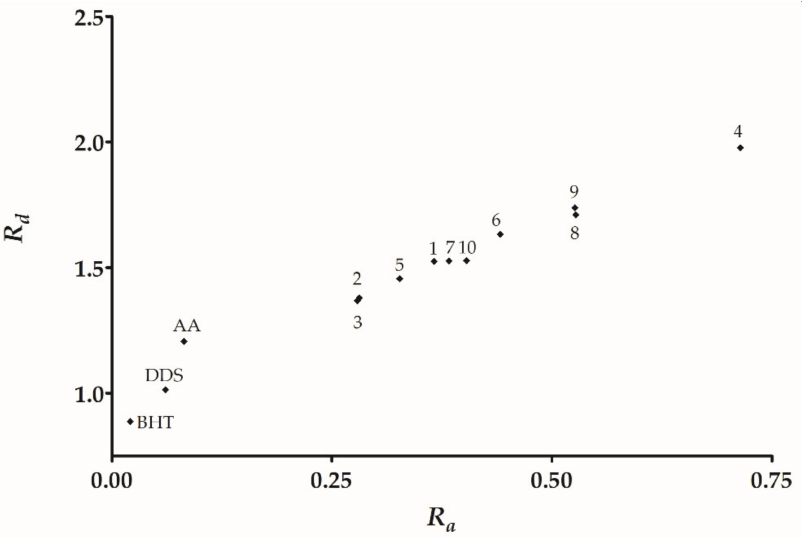
Figure 2. DAM for DDS derivatives 1 – 10 . The break is intended to visualize DDS in the